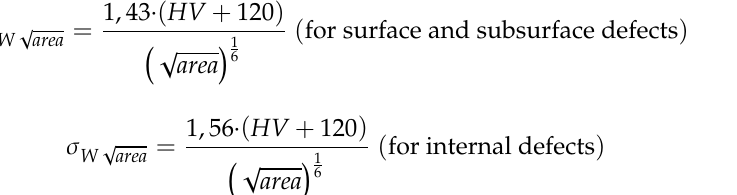
Figure 13. Modified strain-life data following an adapted Murakami’s approach.